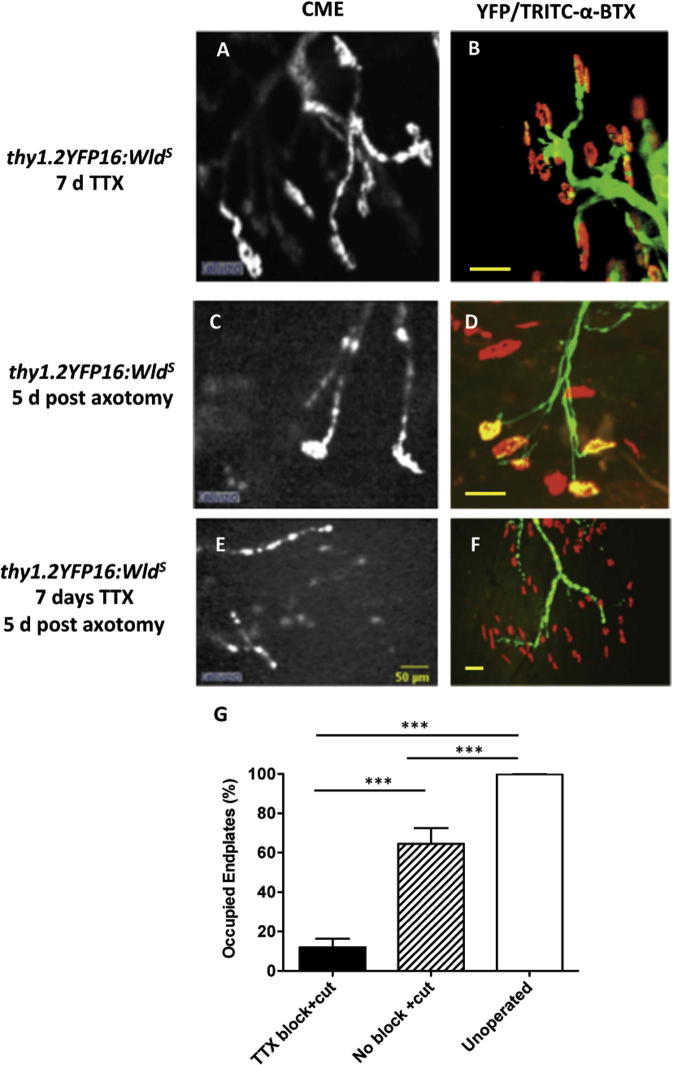
TTX block selectively sensitizes motor nerve terminals. Images obtained in vivo using confocal microendoscopy (CME; panels A, C, E) and conventional fluorescence microscopy (B, D, F) from WldS mice after TTX block alone (A, B), 5 days after axotomy alone (C, D), or 5 days post axotomy with seven preceding days of complete nerve conduction block with TTX (E, F). Triggering degeneration after 7 days of TTX left most intramuscular axons denuded of their nerve terminals. Images digitally adjusted for overall brightness and contrast only. (G) The number of occupied endplates was significantly reduced in lumbrical muscles 5 days post axotomy from mice preconditioned with 7 days TTX block, compared to untreated axotomized (No block + cut), and unoperated controls (mean ± S.E.M., n = 4–7 muscles; P < 0.001, ANOVA/Bonferroni).